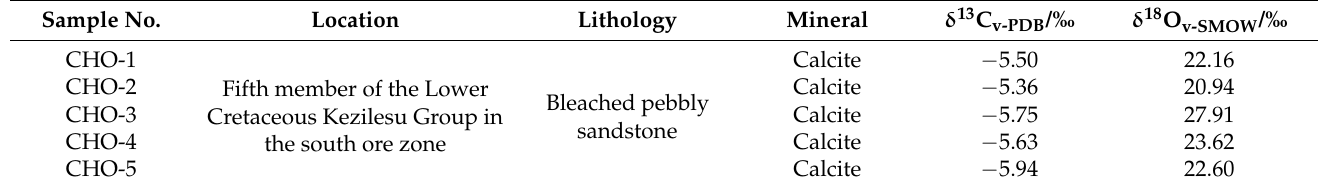
Table 2. C-O isotopic compositions of calcite in the bleached pebbly sandstone of the fifth member of the Lower Cretaceous Kezilesu Group in the Uragen